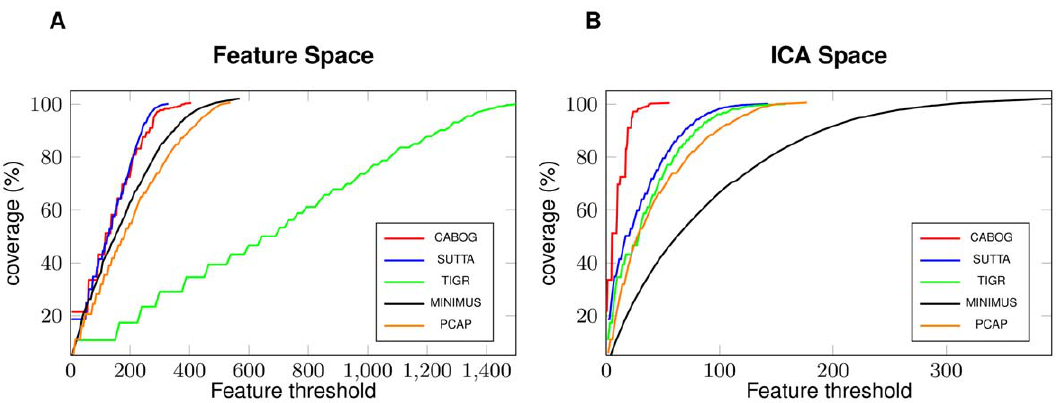
Figure 3. Feature Response Curve and ICA features: Long Reads. Figure A shows the FRC for the 5 assemblers on Brucella suis dataset when using all the feature space. Figure B shows the FRC computed on the ICA-selected features.